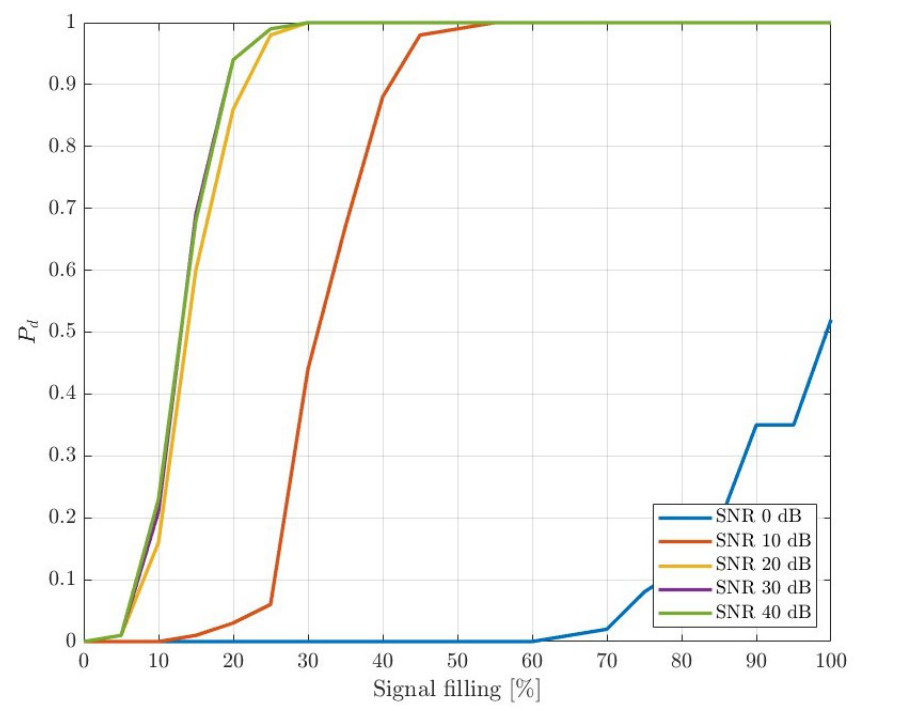
Figure 15. Probability of detection ( P d ) as a function of signal filling ( P fa = 10 − 4 ).